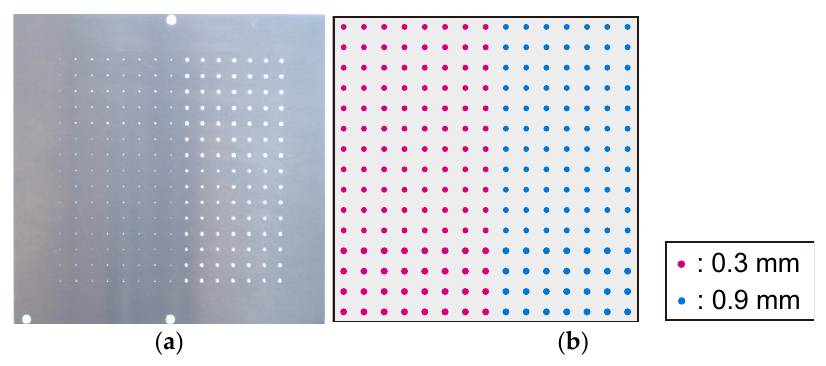
Figure 1. ( a ) Photograph of specimen (A); ( b ) profile sketch of specimen (A).